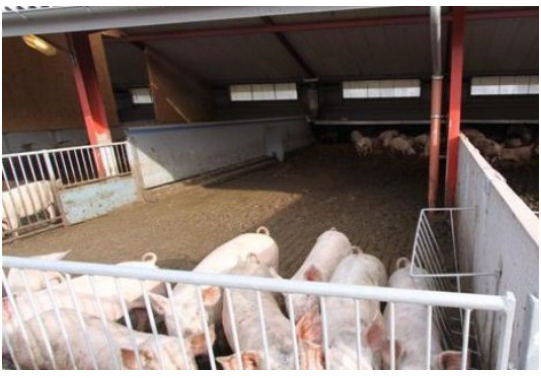
Figure 2. Growing-finishing pigs in outdoor concrete